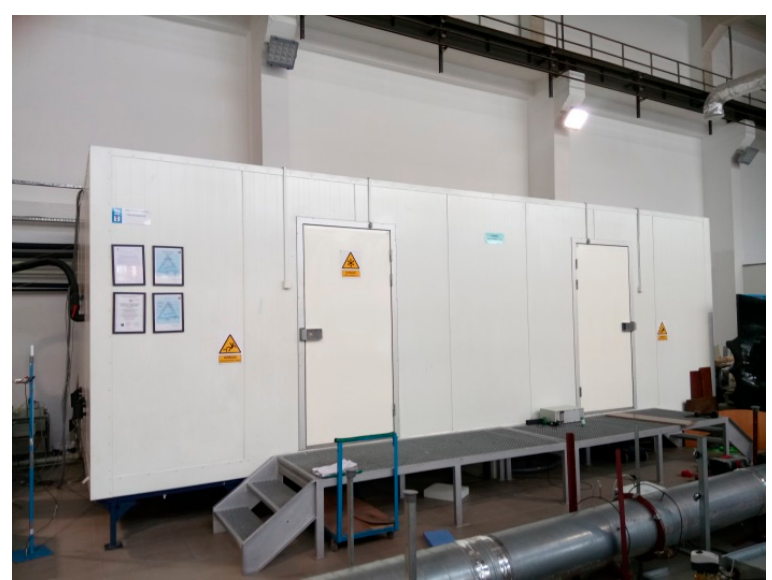
Figure 7. The view of the Laboratory of Thermal Engineering calorimetric chamber situated in Cracow University of Technology, Poland.